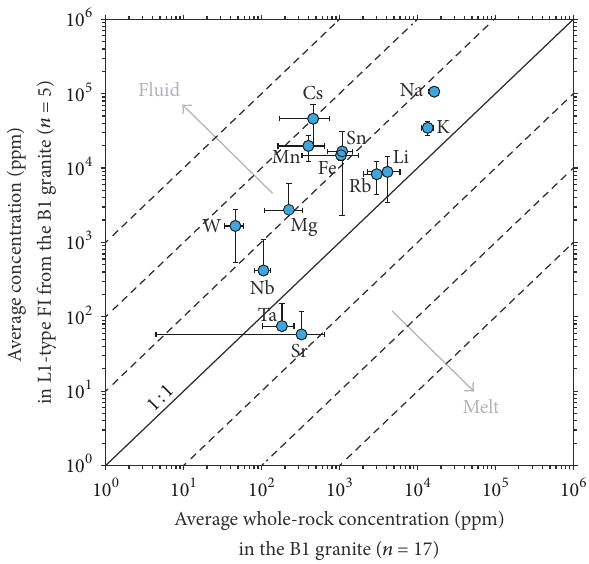
Figure 13: Average concentration of L1-type fluid inclusions (FI) contained in primary quartz from the Beauvoir B1 granite deter- mined by LA-ICPMS (𝑛 = 5) versus average whole-rock concen- tration of the B1 granite (𝑛 = 17) compiled from Cuney et al. [12] and Raimbault et al.